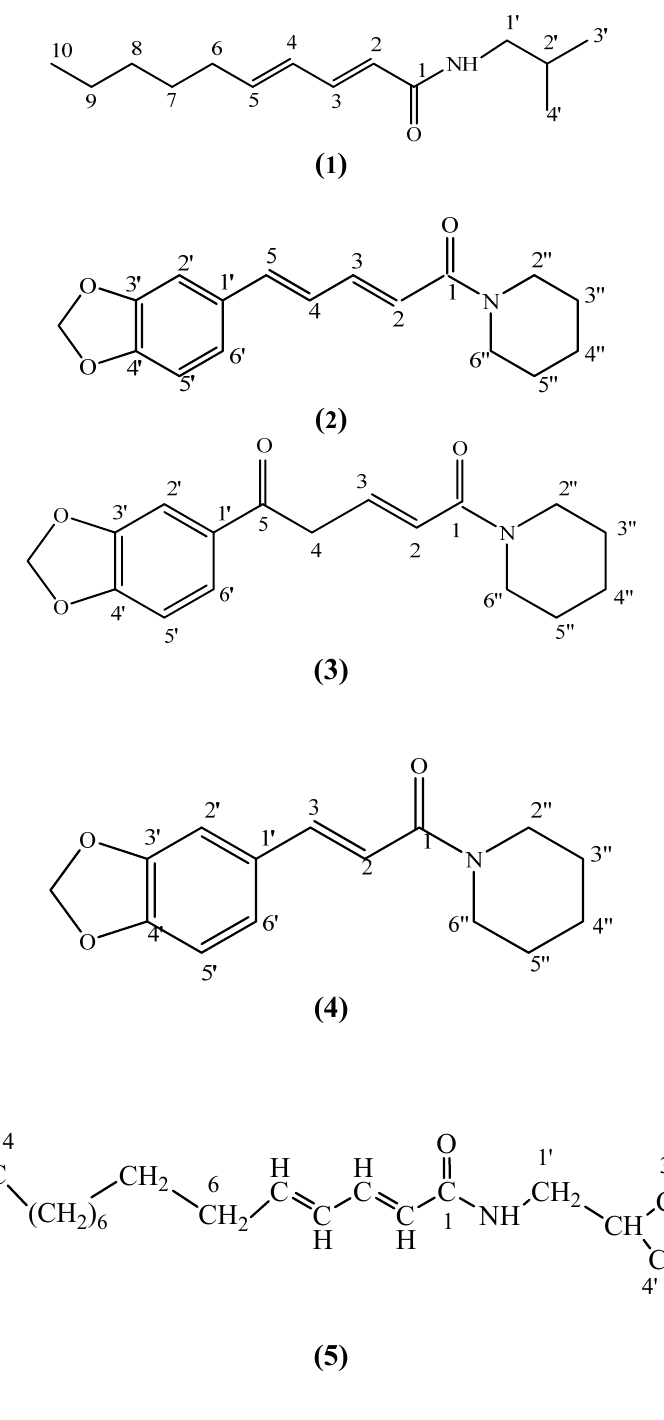
Figure 1. Compound